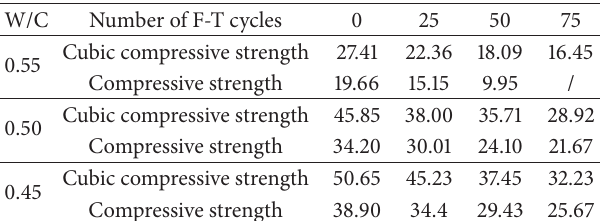
Table 3: Compressive strength of plain concrete after different cycles of F-T (MPa).